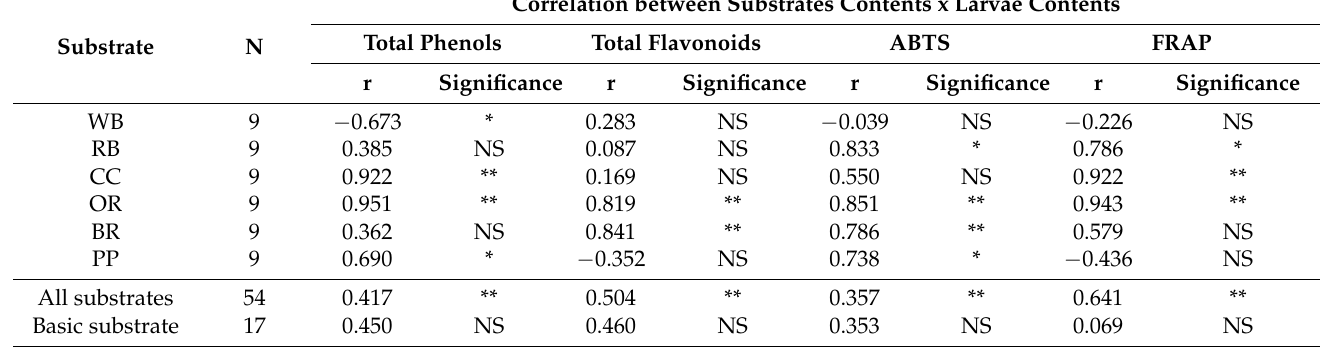
Table 7. Correlation analysis of the content in total phenols, total flavonoids and antioxidant potential measured with two assays (ABTS and FRAP) between the TML and the substrates they were fed with.